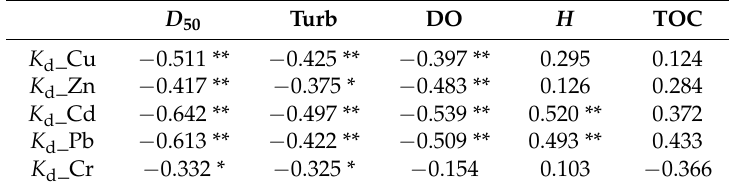
Figure 9. Statistical analysis of the heavy metal partition between the surface sediment and bottom water samples, with the sites from the mainstream and tributaries separately presented. Table 3. Correlation analysis between the K d values and environmental variables. D 50